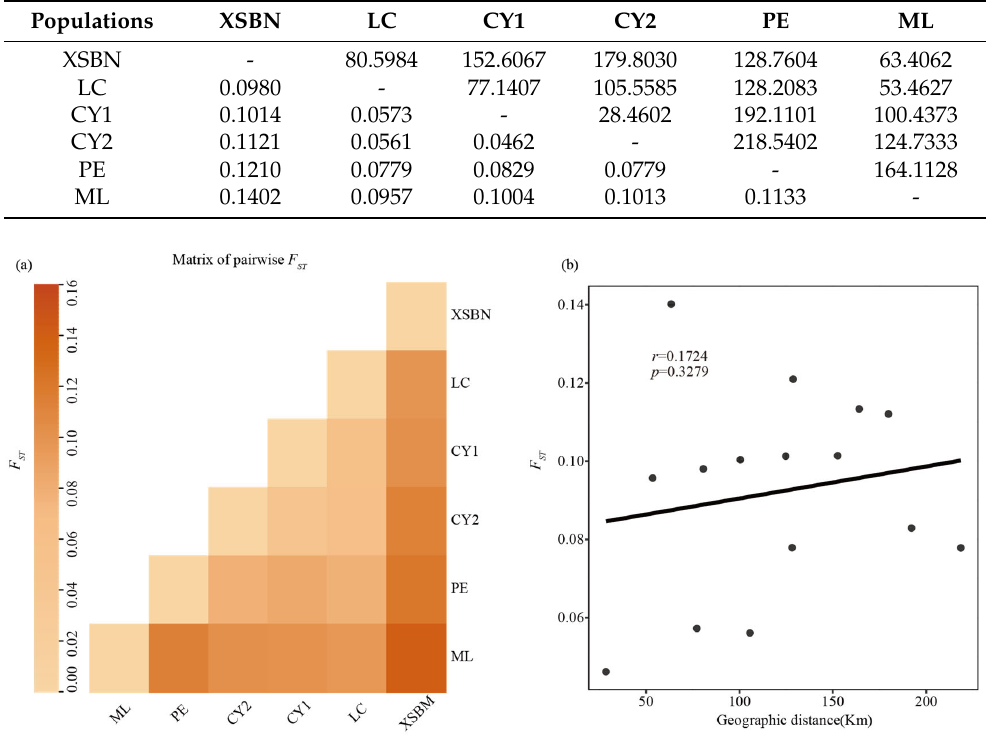
Figure 4. Pairwise F ST for T. doichangensis populations ( a ) and the correlation between genetic distance and geographic distance ( b ). Table 4. Analysis of molecular variance (AMOVA) of the genetic variation in T. doichangensis . Source of